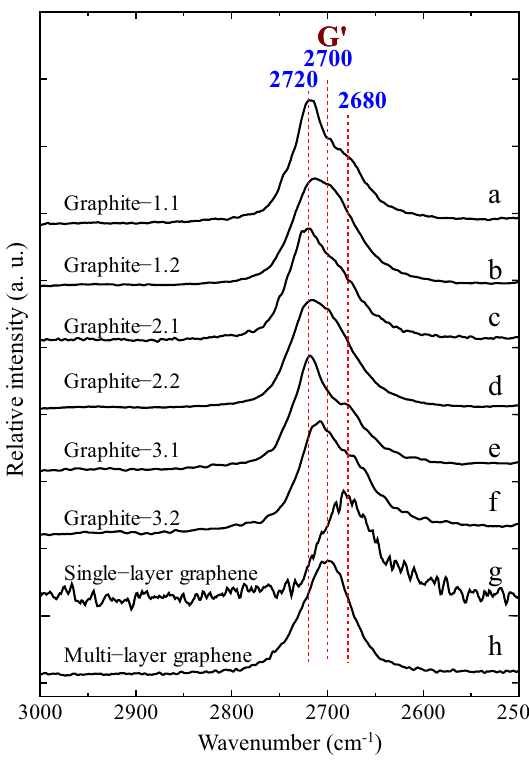
Fig. 1 Raman shifts and spectral line-shapes of G ʹ -bands of graphene and graphite samples: a , graphite-1.1; b , graphite-1.2; c , graphite-2.1; d , graphite-2.2; e , graphite-3.1; f , graphite-3.2; g , single-layer graphene; h , multi-layer grapheme. Graphite-1, -2, and -3 were purchased from Sigma-Aldrich Co. LLC (USA), Thermo Fisher Scientific Corp. (USA), and FUJIFILM Wako Pure Chemical Corp. (Japan), respectively. Single-layer and multi-layer graphene samples deposited on a metal plate were obtained from Graphene